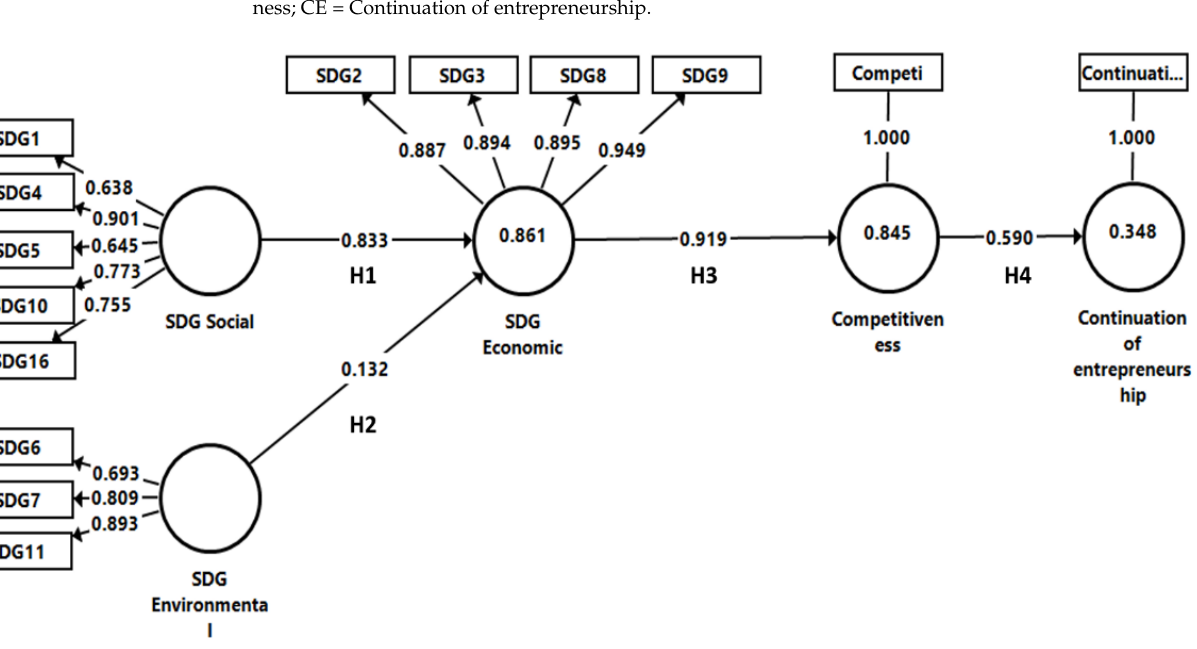
Table 5. Specific Indirect Effects.